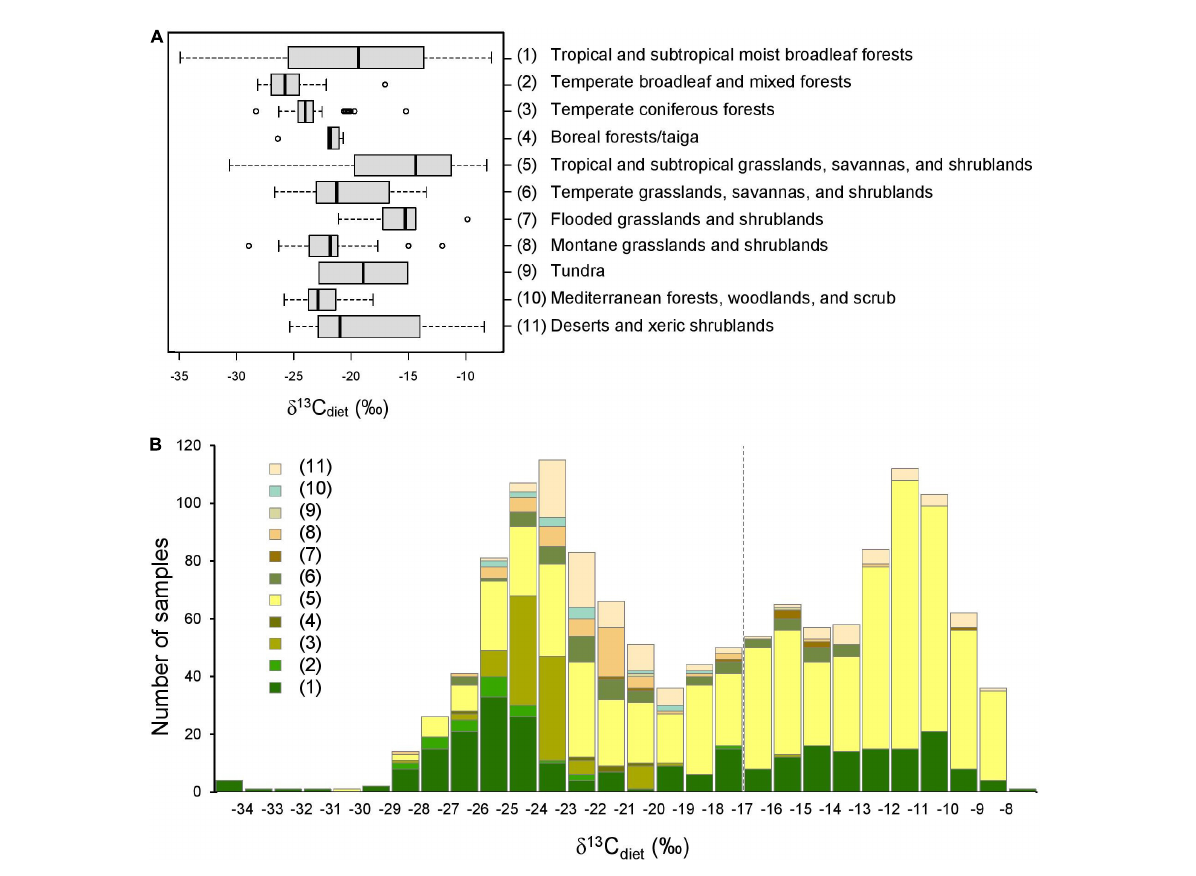
FIGURE4 Comparison of δ 13 C diet values among 11 terrestrial ecoregions. (A) Boxplots showing the (non-outlier) range (whiskers), first and third quartiles (box), median (vertical line), and outliers (circles) of δ 13 C diet values in each ecoregion. (B) Histogram of δ 13 C diet values of the ecoregions. Numbers in legend correspond to ecoregions in (A) , and the color scheme corresponds to that of Figure 1 . Dashed vertical line is the C 3 -C 4